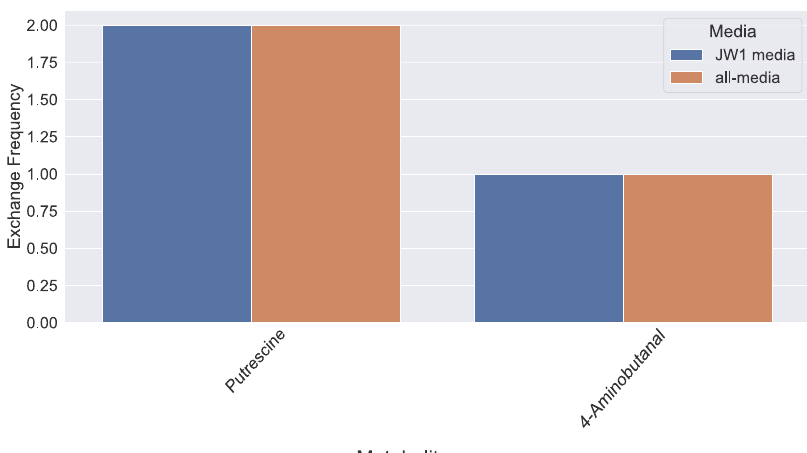
Fig. 4 Metabolic support received and provided by Candidatus Pacearchaeota archaeon UWMA 0287. These plots depict the set of possible metabolites ( a ) accepted and ( b ) received by Candidatus Pacearchaeota archaeon UWMA 0287 from other microbes through the metabolic exchange. The Y-axis in this plot shows the number of interaction pairs in which that exchange has occurred, with 97 being the highest number of possible pairs for a microbe in a 98-member